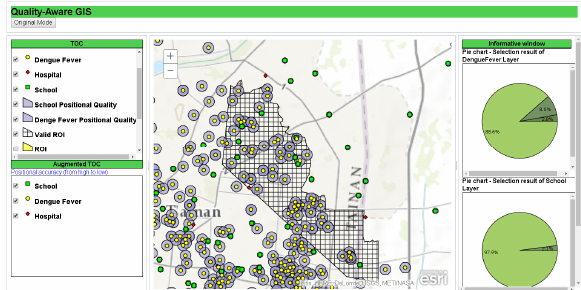
Figure 12. Virtual layers for presenting positional accuracy (translucent purple area)